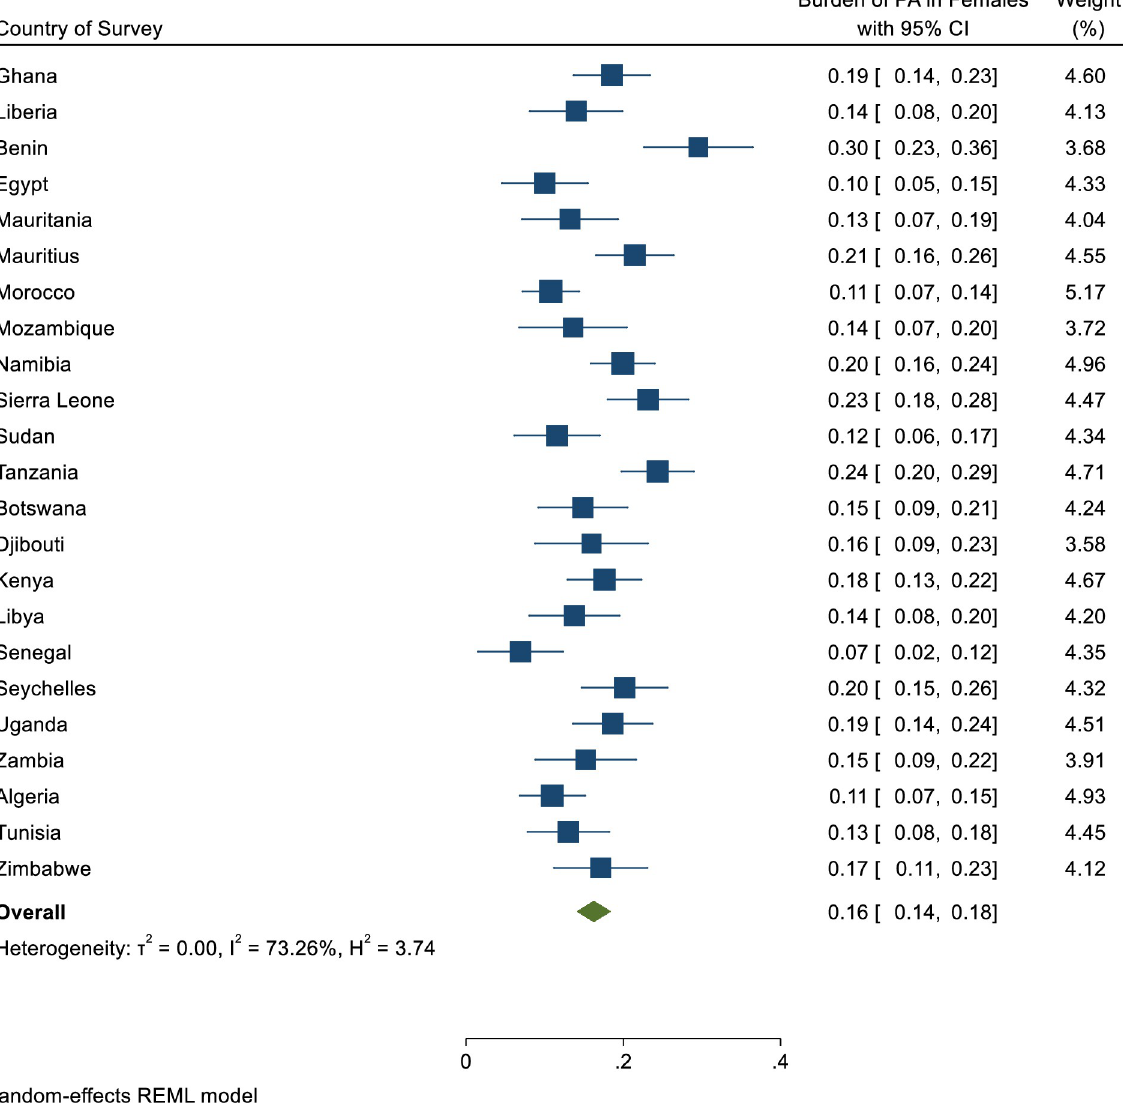
Fig 3. Pooled estimated prevalence of sufficient physical activity level across 23 African countries stratified by female gender. Burden as used in Fig 3 is a general term for prevalence in burden of disease studies or epidemiological studies.